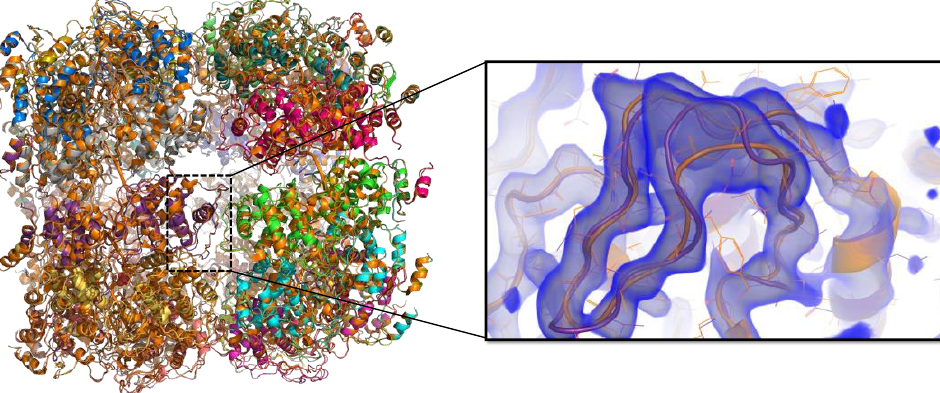
Figure 5. Re-refinement of the circular polymeric N 11 − RNA complex crystal structure. The different N subunits of the re-refined model are shown in cartoon representation with different colors for each chain and superimposed onto the original model (PDB ID 2GTT, shown in orange). The close-up view shows an excerpt of the region that was rebuilt (in orange), with the experimental 2Fo-Fc map shown in volume representation in blue and contoured at 1σ (drawn with PyMOL).